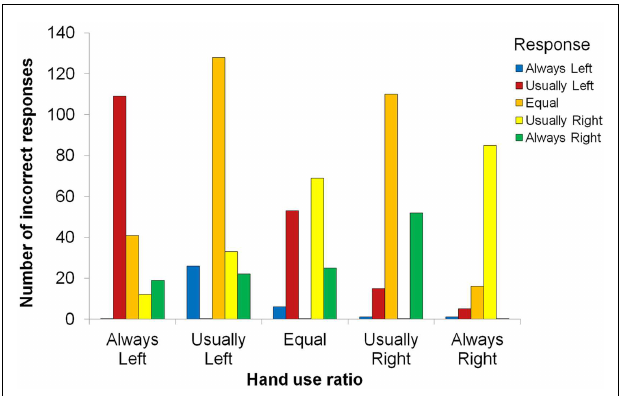
FIGURE 3 | Distribution of incorrect responses as a function of hand-use ratio